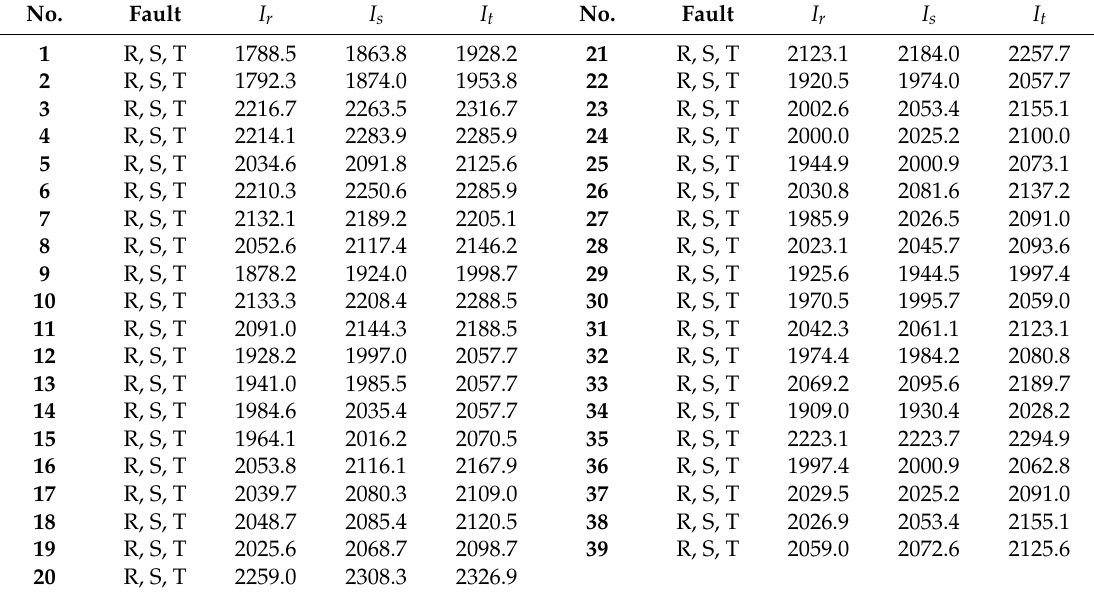
Table 1. Time delay operations of OCR* in GIPAM-2200DG**. Unit: A (Measured from 19 October